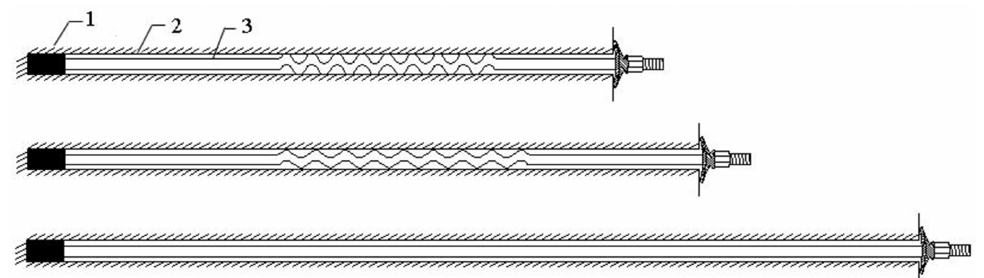
Figure 12. The wave-type bolt’s construction diagram. 1—Prolonged anchor section, 2—Sine-wave structure section, 3—Pallet, 4—Fastening nut, 5—Threaded section, 6—Stirring wing. Note: ( a ) The wave-type bolt; ( b ) Sine-wave structure section.